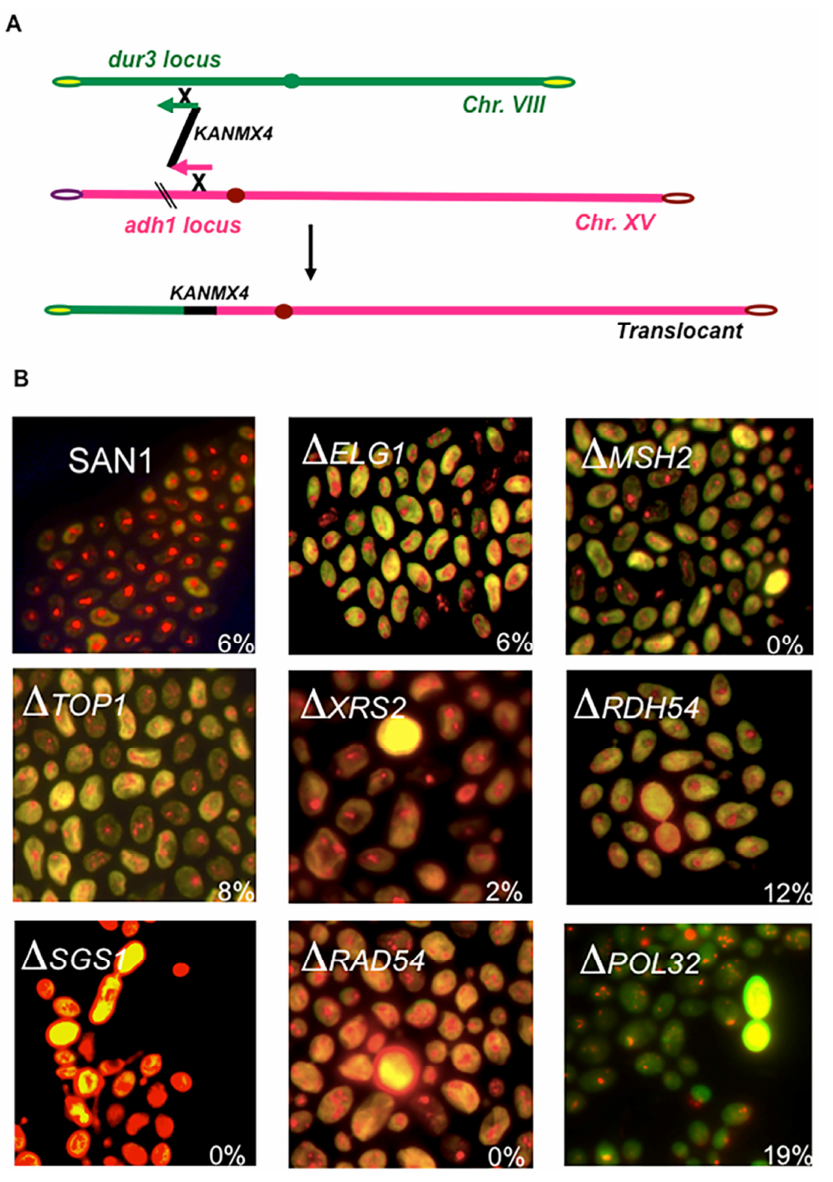
FIGURE 2: (A) Schematic representation of the BIT translocation between the adh1 locus (Chromosome XV) and the dur3 locus (Chromosome VIII); arrows at the end of the homology indicate the directionality of the translocation. (B) Fluorescent microphotography of the wild type yeast diploid SAN1 and several deletants of genes involved in the BIT regulatory pathway. The cells were stained with the Live/Dead Viability kit (Molecular Probes) using 6 μM as final dye concentration and fluorescein and rhodamin filters. Dead cells appear as yellow. The percentage of the trans- locants out of the total number of trans- formants obtained with the translocation represented in (A) is reported for each